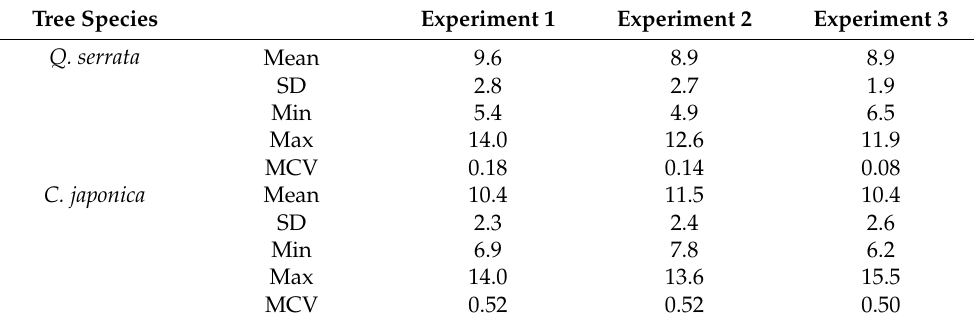
Table 1. Volume (ml) of xylem sap collected in water-absorbing resin for 1 month. Tree Species